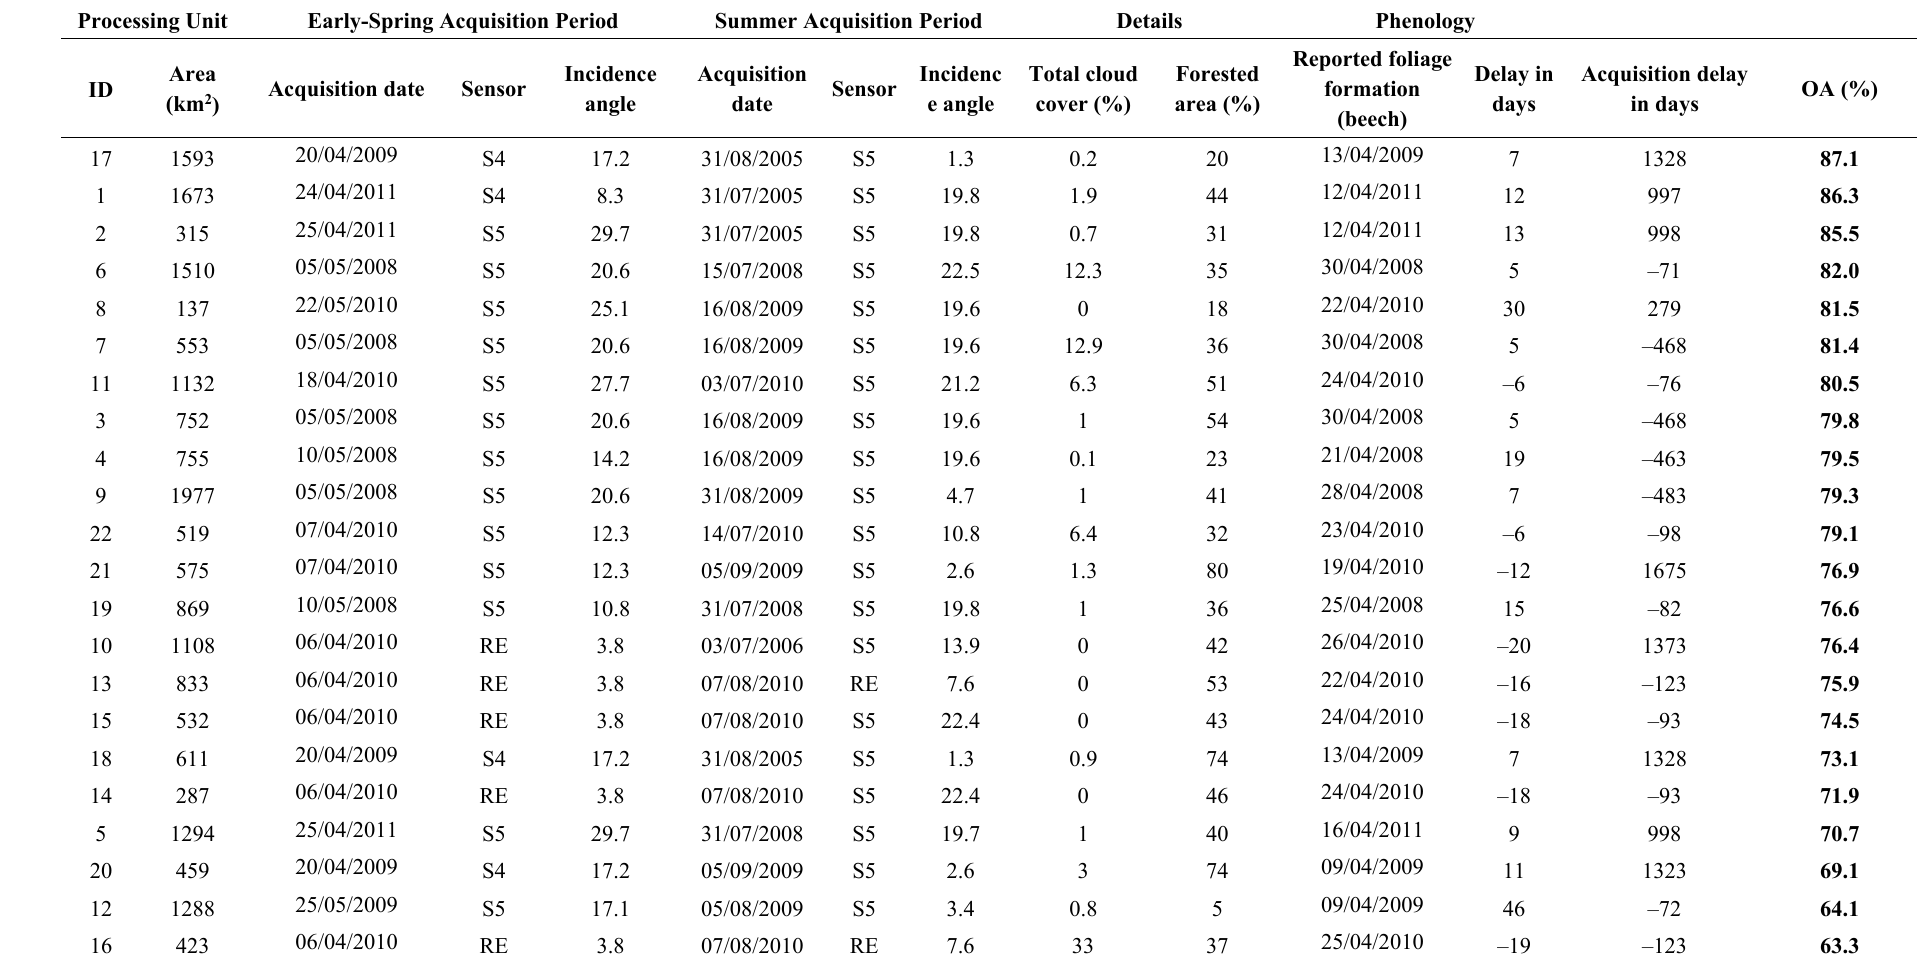
Table 5. Processing unit characteristics and overall classification